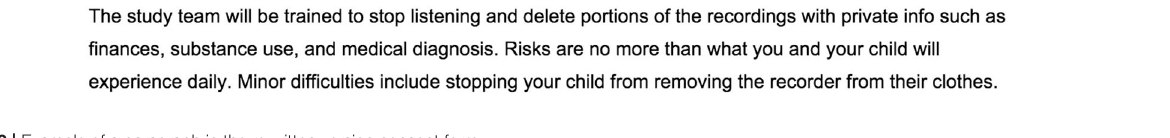
FIGURE 2 | Example of a paragraph in the rewritten version consent form.